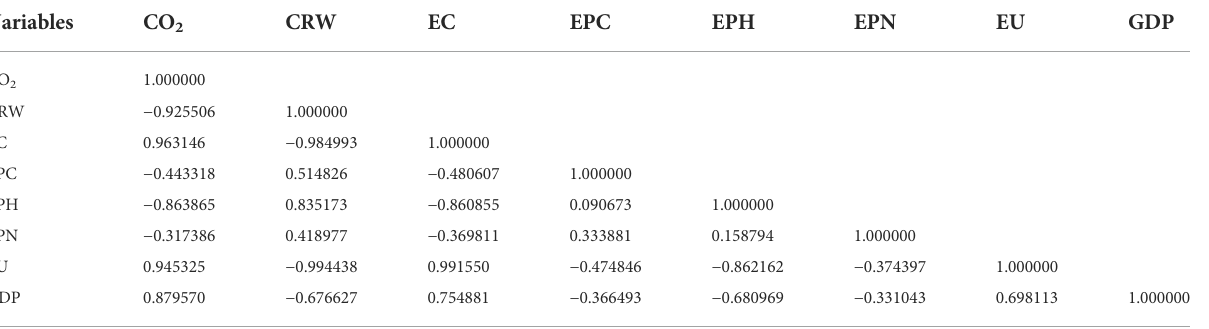
TABLE 3 Correlation matrix